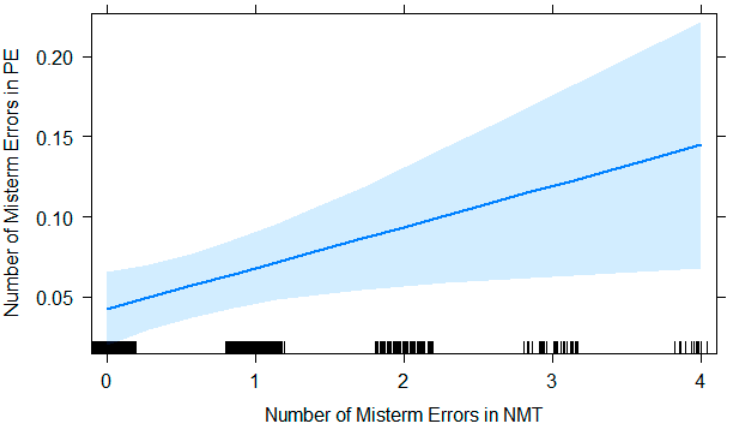
Figure 3. E ff ect of register errors in NMT on register errors in NMTPE. Figure 3. Effect of register errors in NMT on register errors in NMTPE.